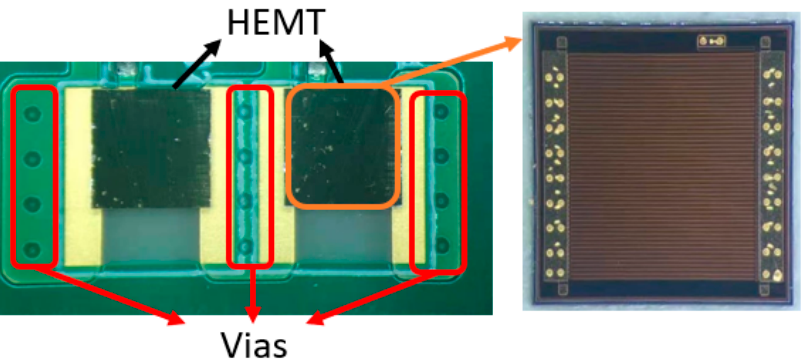
Figure 3. Microscope photograph of the power loop and the golden ball distribution of the HEMT.